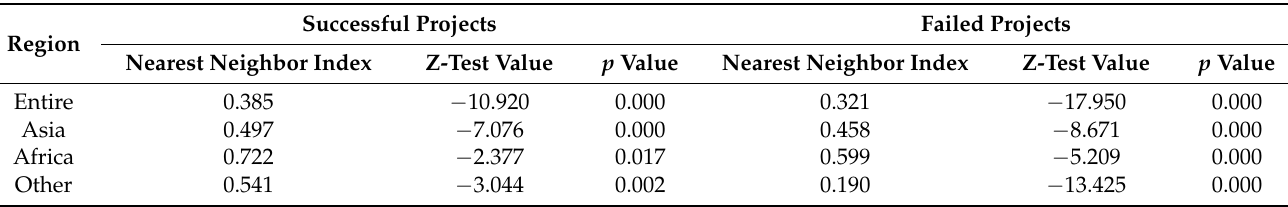
Table 3. Nearest neighbor index measurement results.